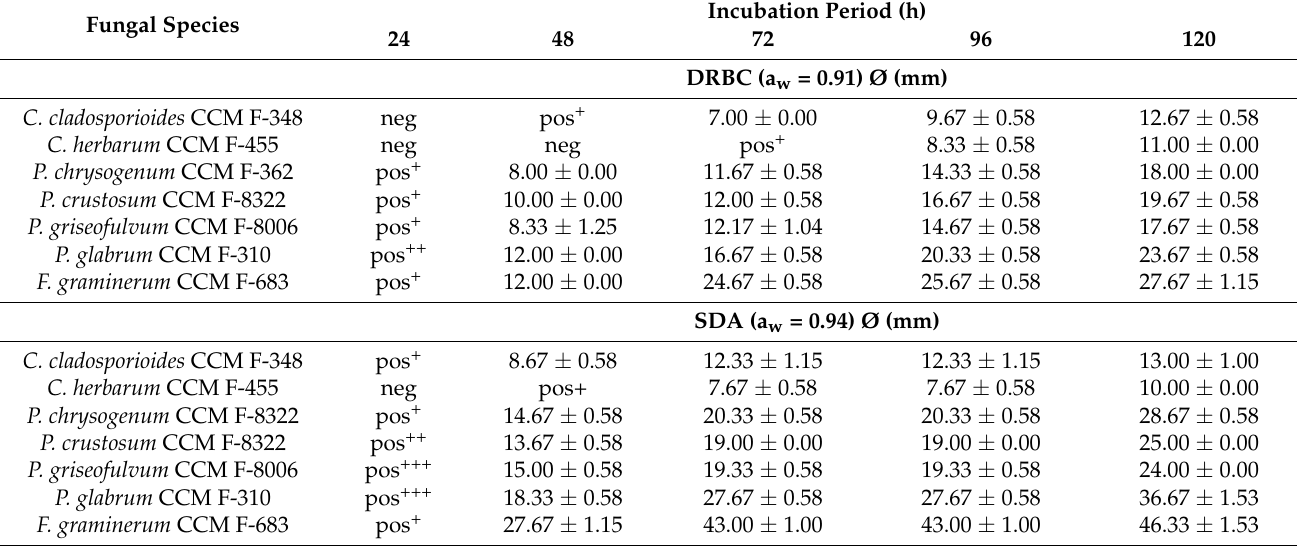
Table 4. Colony diameters (Ø) of Cladosporium , Penicillium and Fusarium species grown on Dichloran Rose Bengal Chloram- phenicol agar (DRBC) and Sabouraud Dextrose Agar (SDA) (mean ± SD). Fungal Species